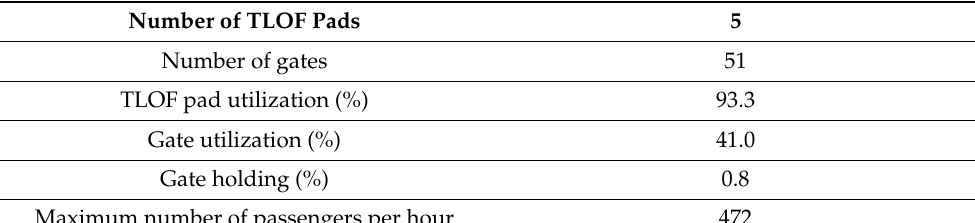
Figure 43. Capacity of the Gimpo Airport vertihub. Table 12. Analysis results of the vertihub of the Korea Airports Corporation.